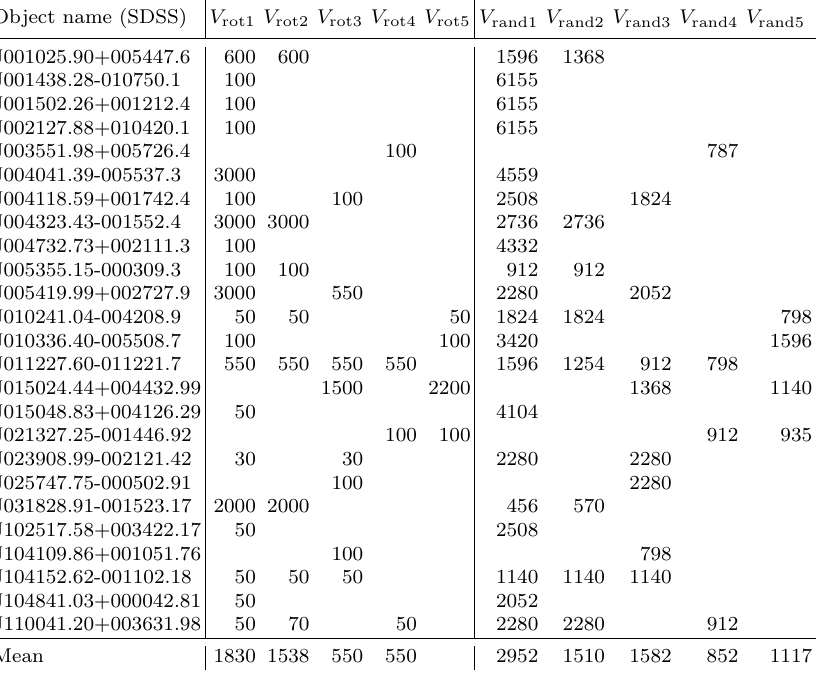
Table 2. Rotational and random velocities